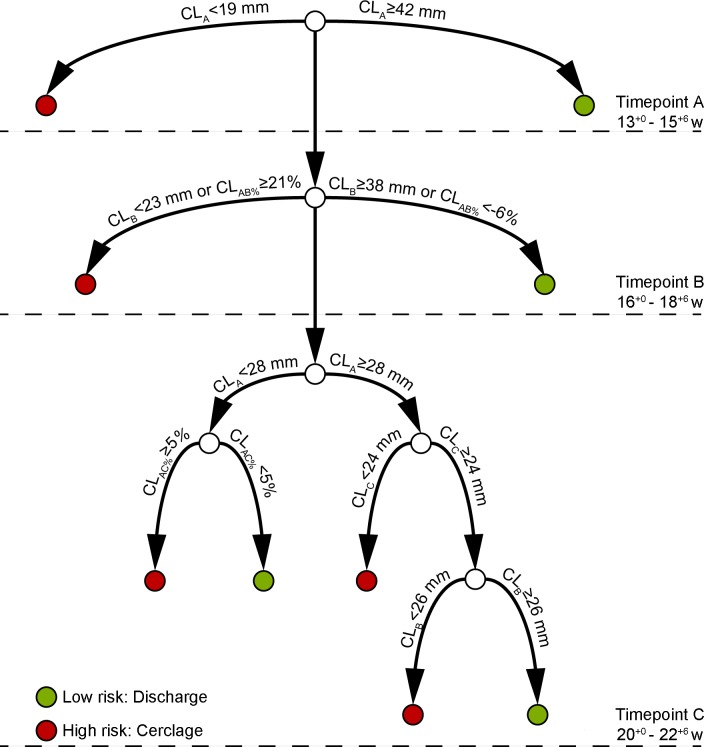
Triage Screening Model for pregnancies post excisional cervical treatment for the prevention of preterm birth <37weeks.A triage screening model was developed using decision tree analyses to determine optimum thresholds of CL and % change in CL between screening timepoints A (13+0–15+6 weeks), B (16+0–18+6 weeks) and C (20+0–22+6 weeks), to ensure appropriate allocation of resources. This model identifies pregnancies at low-risk of preterm birth enabling safe and timely discharged from cervical length surveillance (green dot). Similarly early identification of high-risk pregnancies allows for timely cerclage intervention (red dot). Serial CL surveillance can therefore reserved for pregnancies considered at intermediate risk, requiring further observation. CL = cervical length (mm); CLAB%
= percentage change in CL (mm) between screening time points; w = weeks.